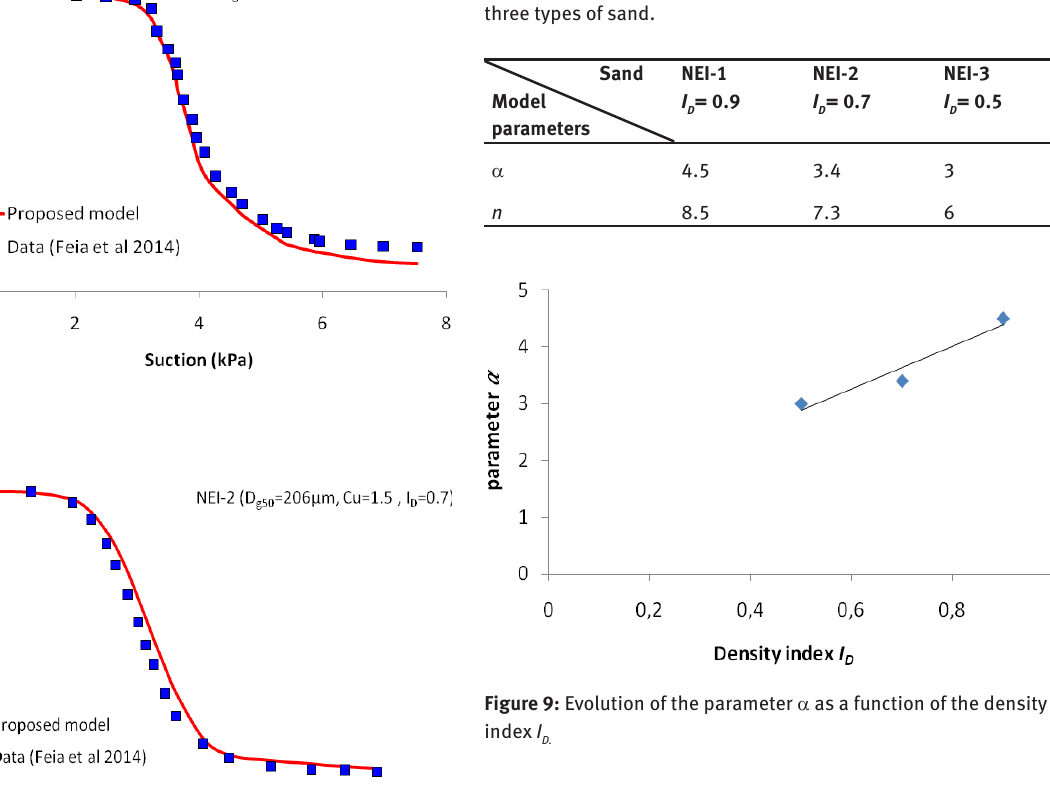
Table 2: Values of the parameters of the proposed model for the three types of sand.